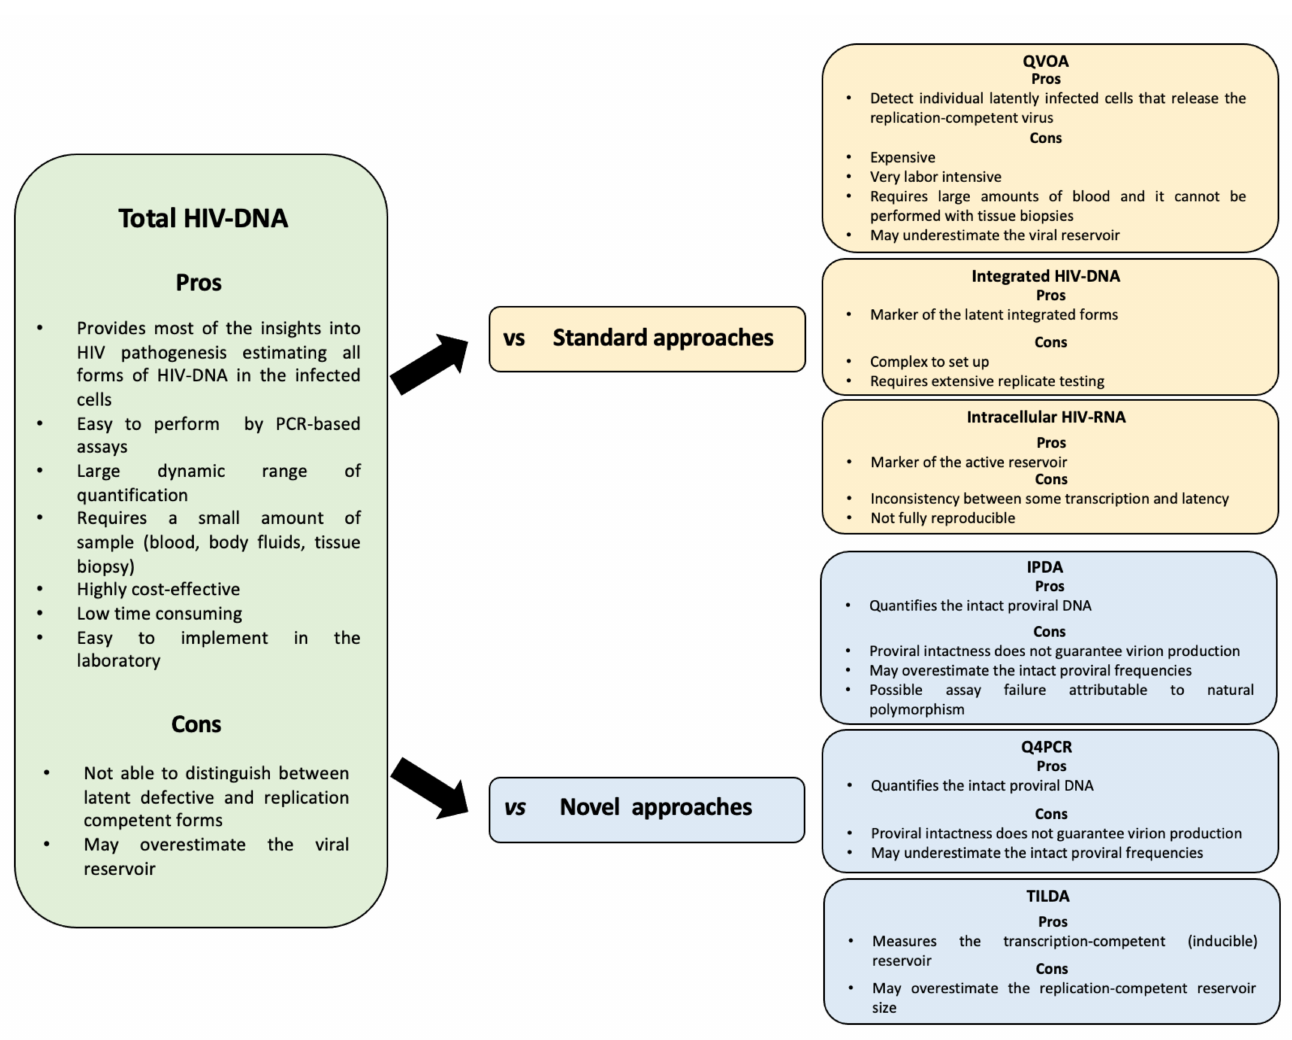
Figure 1. Total HIV DNA vs other approaches for quantifying the